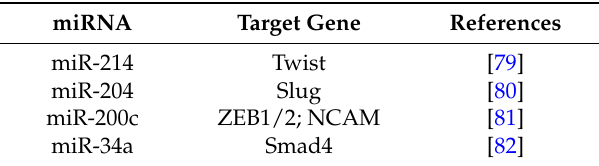
Table 2. miRNAs whose inactivation leads to EMT